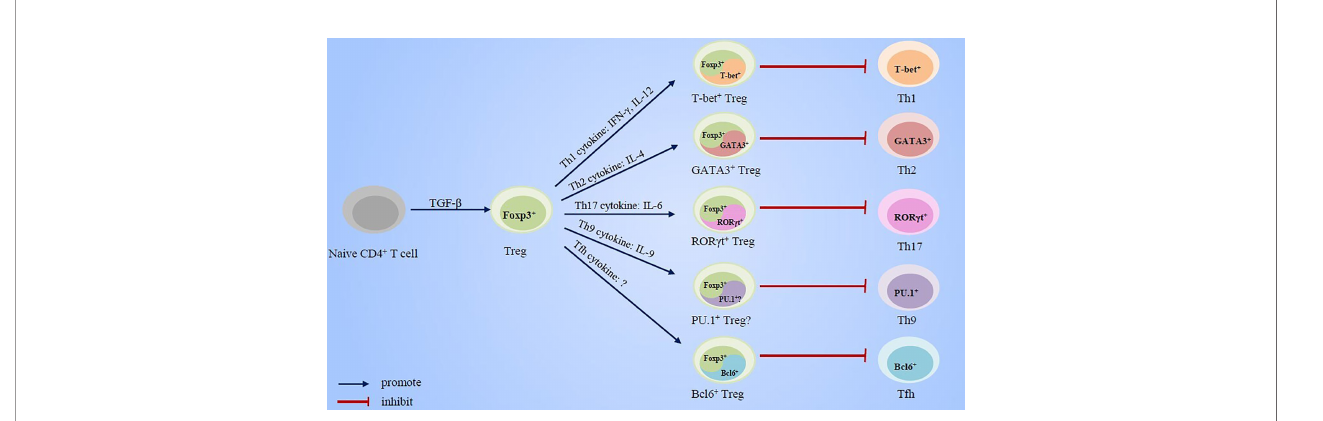
FIGURE 1 | Cytokines and transcript factors of effector Th cells promote the specialization and enhancement of Treg cell